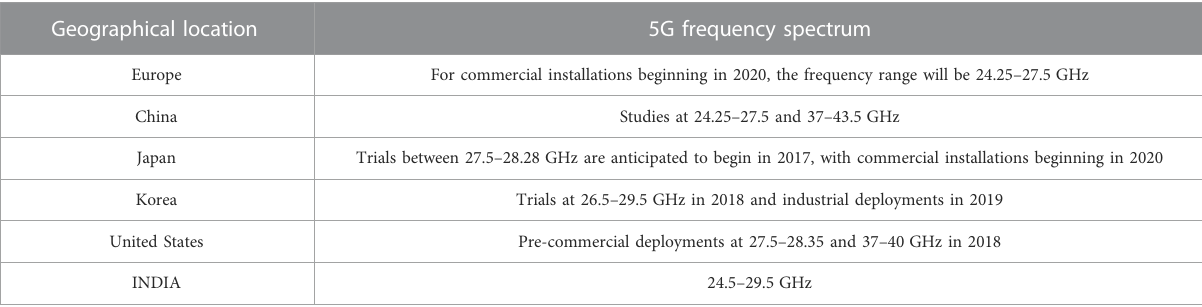
TABLE 1 5G frequency band spectrum of different geographical areas. Geographical location